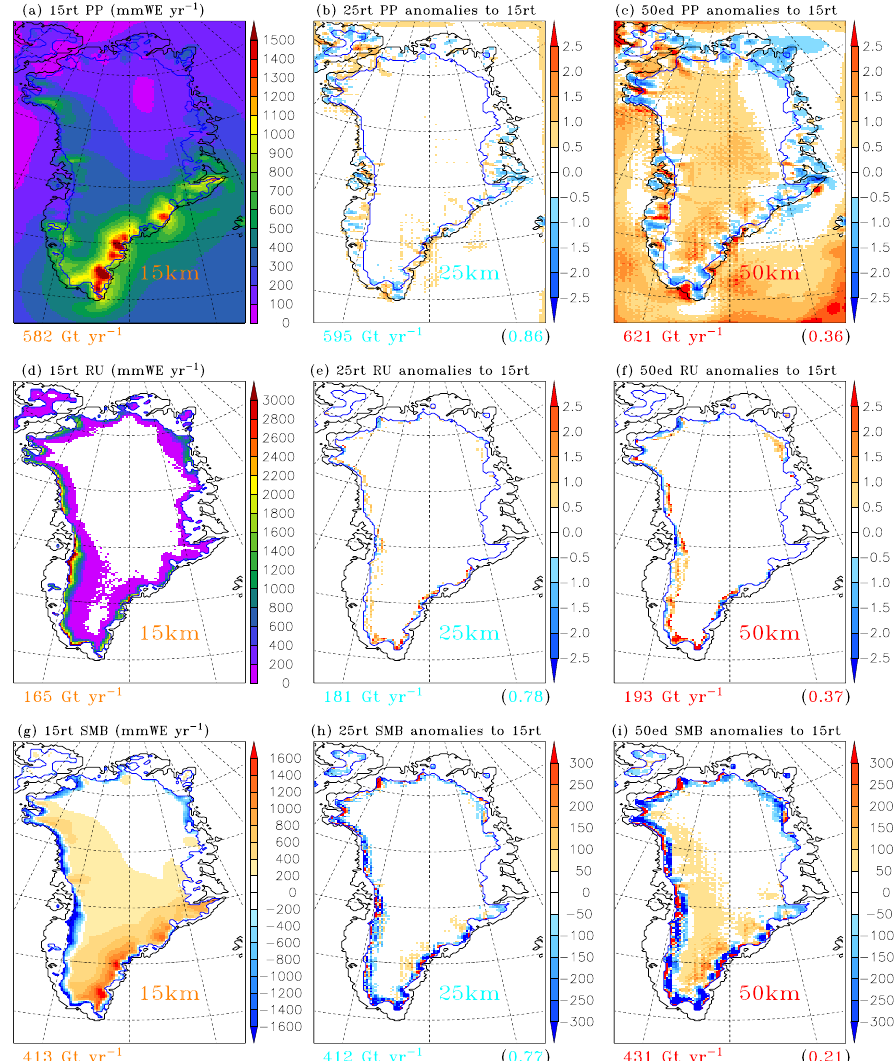
Fig. 4. (a) Annual precipitation (mmWEyr − 1 ) simulated by the MAR model at 15km resolution (15rt) over the 1990–2010 period. (b– c) Annual precipitation anomalies (in standard deviation) of the 25 and 50km resolution MAR outputs (25rt and 50ed) interpolated onto the 15km MAR grid, compared to (a) . On the bottom left side of each view is the annual amount of precipitation (Gtyr − 1 ) on the ice sheet mask common to all the spatial resolutions, drawn in solid blue line. On the bottom right side of each view, in brackets, is the skill score of the 25rt and 50ed field compared to the 15rt outputs, on the common GrIS mask. (d–f) The same as (a–c) , but for the annual run-off (mmWEyr − 1 ). (g–i) The same as (d–f) , but for the annual SMB (mmWEyr − 1 ). See the Supplement for the 20, 30 and 40km resolution